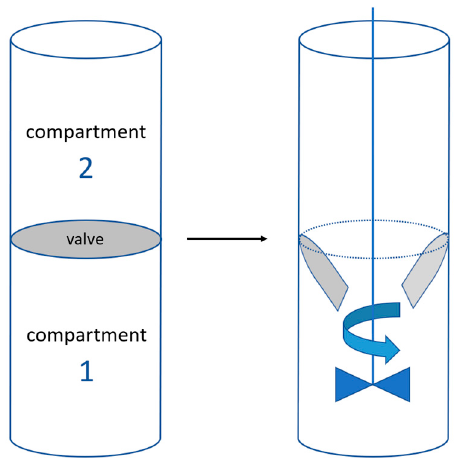
Figure 1. “Mixing batch” cell mechanism, including two compartments separated with a valve. Flour and sweeteners were placed in compartment n°1, and water in compartment n°2. When the equilibrium state is reached in the DSC, the valve is opened, the liquid enters into contact with the powders and the mixture is homogenized.